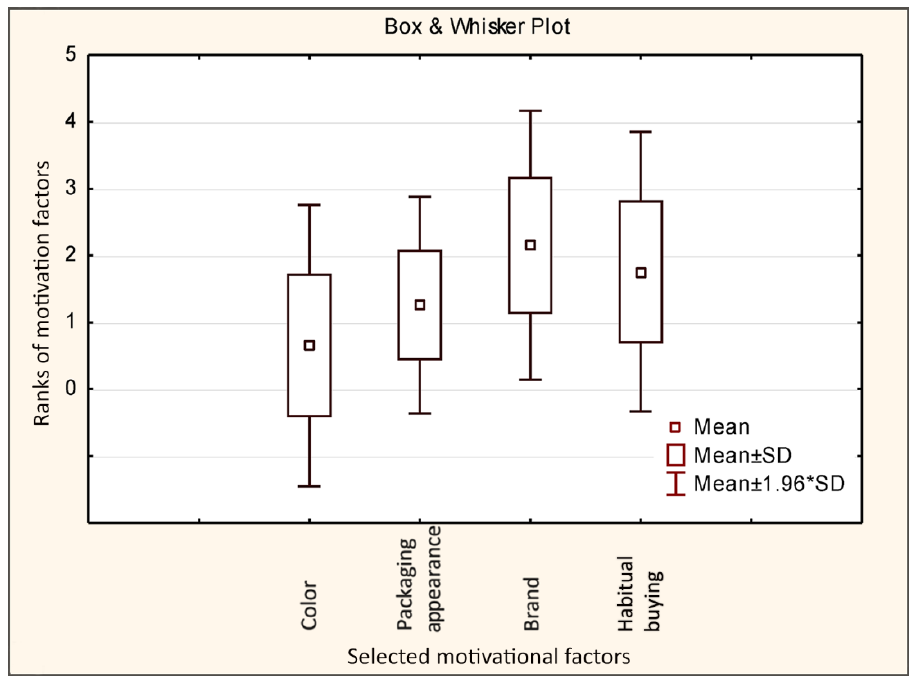
Figure 5. Box & Whisker chart of the motivational factors which most effect the purchase of chocolates on analog media.